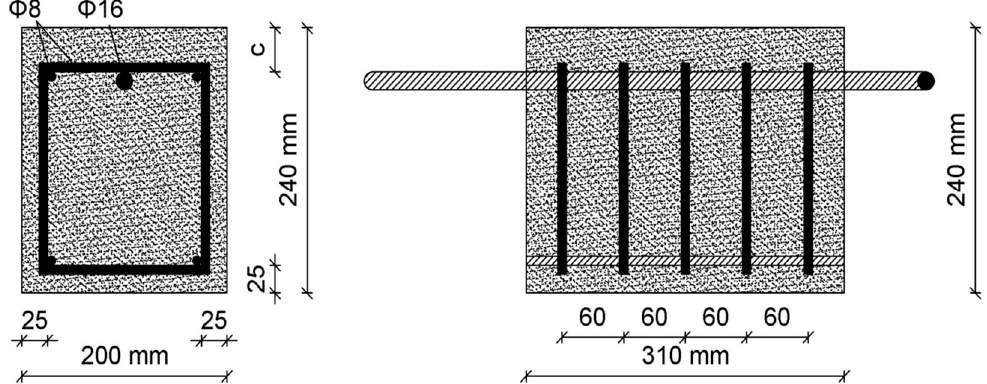
Figure 2. ( a ) Typical cross-sectional view with cover thickness = 25 mm; ( b ) longitudinal view (dense stirrups Φ 8/60 mm).